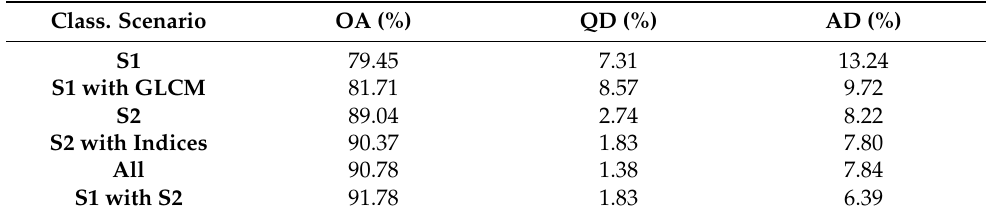
Table 6. Mean overall accuracy (OA), quantity, and allocation disagreement (QD and AD) calculated from 10 random trials ranked in ascending order of